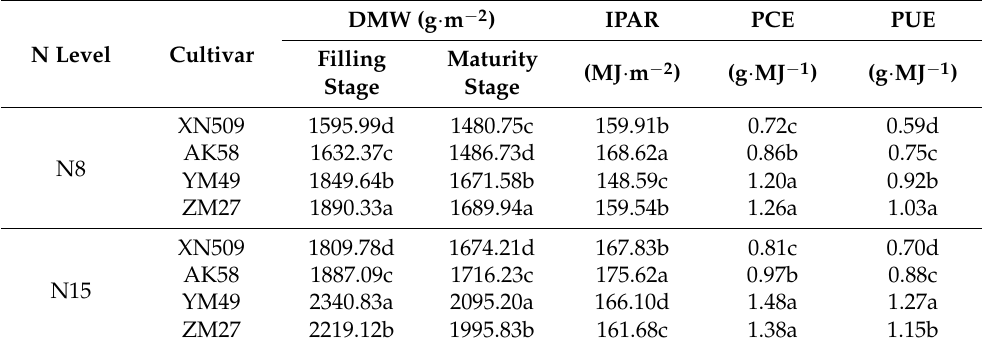
Table 5. The vertical distribution of DMW, PCE, and PUE of two N-efficient and two N-inefficient winter wheat varieties under different N levels.